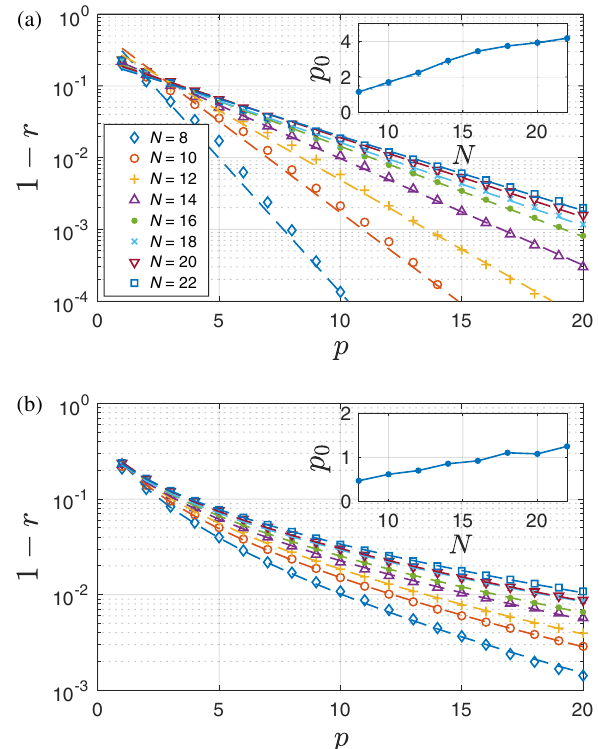
FIG. 4. Average performance of the QAOA as measured by the fractional error 1 − r , plotted on a log-linear scale. The results are obtained by applying our heuristic optimization strategies FOU- RIER to up to 100 random instances of (a) u3R graphs and (b) w3R graphs. Differently colored lines correspond to fitted lines to the average for different system size N , where the model function is 1 − r ∝ e − p=p 0 for unweighted graphs and 1 − r ∝ ffiffiffiffiffiffiffiffi p p=p 0 e − for weighted graphs. The insets show the dependence of the fit parameters p 0 on the system size N